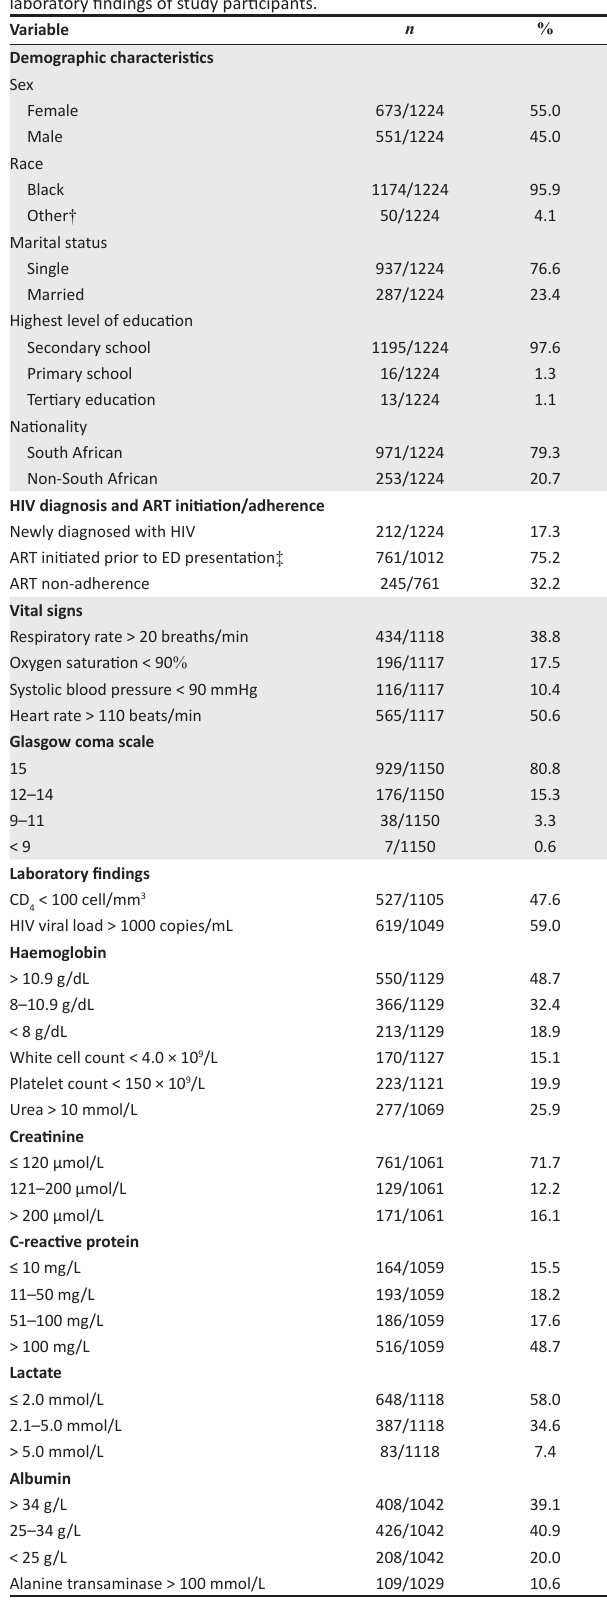
TABLE 2: Description of demographic characteristics, human immunodeficiency virus diagnosis, antiretroviral therapy initiation and adherence, vital signs and laboratory findings of study participants.